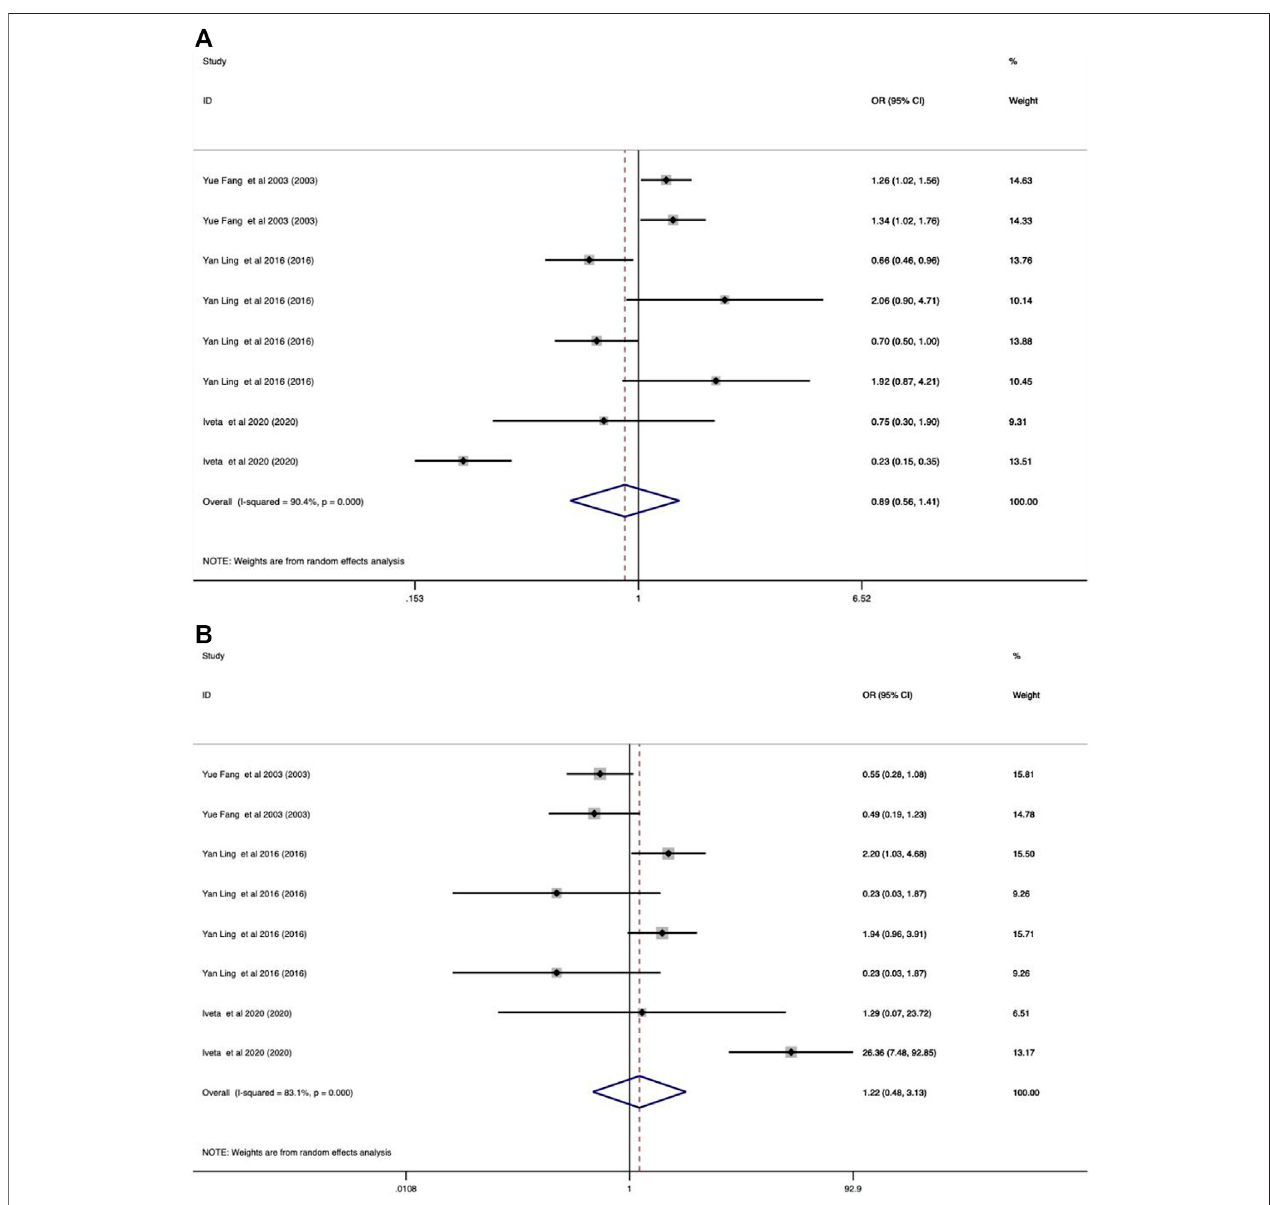
FIGURE 6 | Forest plots of all selected studies on the association between VDR Cdx-2 polymorphism and the risk of osteoporotic fracture in different races [ (A) allele model, (B) additive model, (C) dominant model, and (D) recessive model].